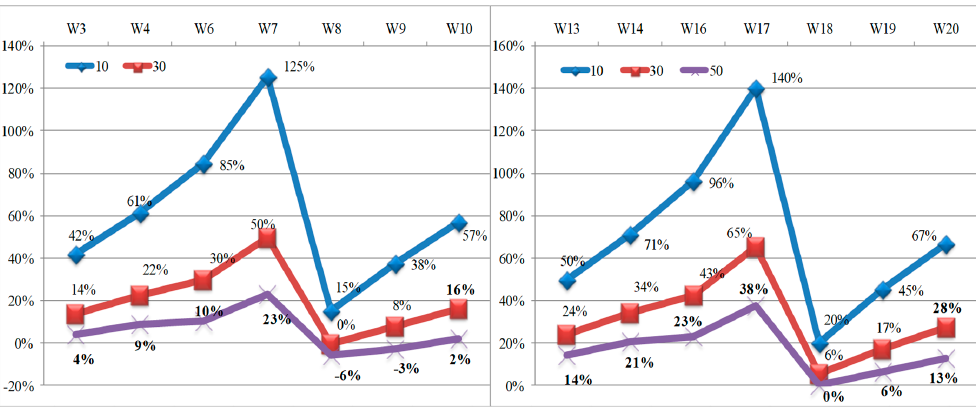
Figure 5. NPV of the economic (including A1–A5, B2–B4 and C2–C4 and D stages) and energy (for B6 substage) costs of each external wall alternative.